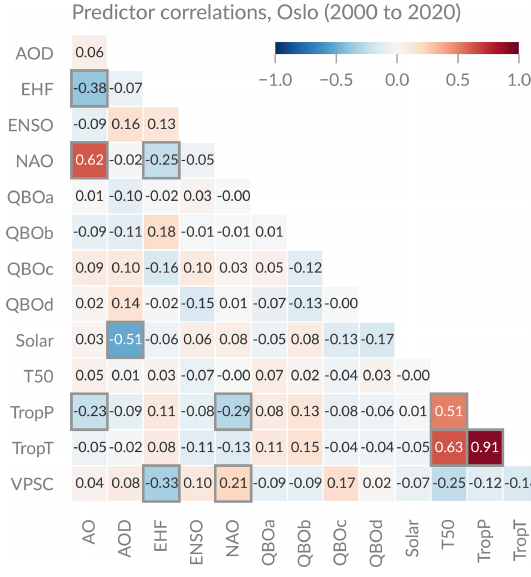
Figure 4. Pearson correlation coefficients of various predictors that are commonly used to account for natural ozone variability. The predictors that are location-specific are shown for Oslo (TropP, TropT, and T50); the other predictors are station-independent. Sig- nificant correlations are marked by a grey border. The significance has been tested with a p value of 0.05 using a multiple test to reduce the possibility that a correlation is significant by chance (adjusted p